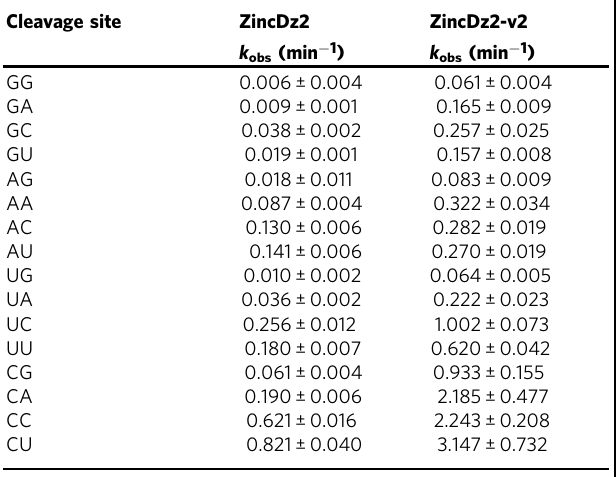
The ZincDz2 (ZincDz2c, ZincDz2t, ZincDz2a, and ZincDz2) and ZincDz2-v2 (ZincDz2c-v2, ZincDz2t-v2, ZincDz2a-v2, and ZincDz2g-v2) were incubated at 37°C for designated period of time(0,1,3,10,30,or60min)inthebuffer(50mMHEPES,pH7.4and150mMNaClincluding 0.8mM ZnCl 2 . ZincDz2c, and ZincDz2c-v2 for the cleavage sites of GG, GA, GC, and GU; ZincDz2t, and ZincDz2t-v2 for the cleavage sites of AG, AA, AC, and AU; ZincDz2a and ZincDz2a-v2 for the cleavage sites of UG, UA, UC, and UU; and ZincDz2 and ZincDz2c-v2 for the cleavage sites of CG, CA, CC, and CU were used to cleave each substrate. The data shown are presented as means ± SD from three independent